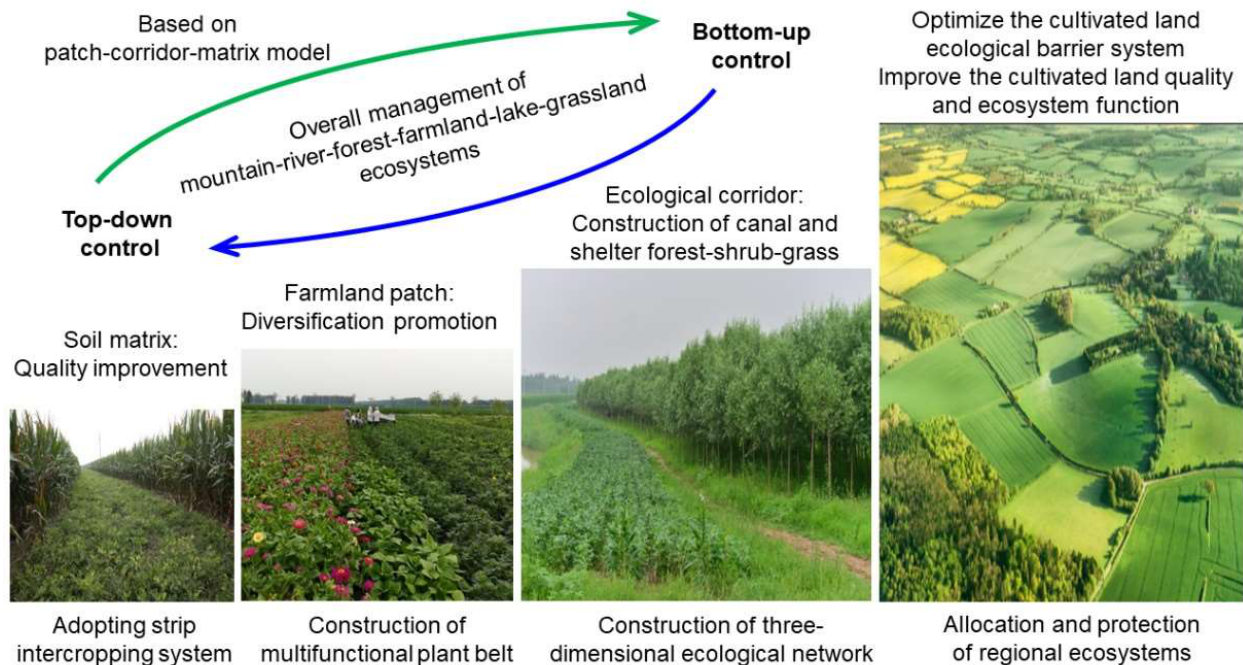
Figure 5. Implement a synergetic development strategy of mountain–river–forest–farmland–lake– grassland–sandy land ecosystems.